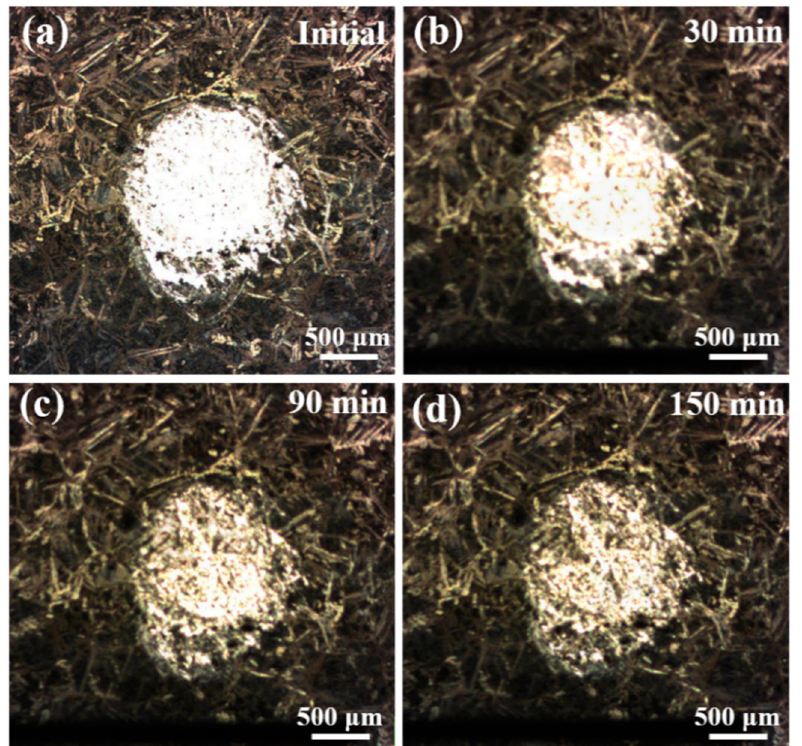
Figure 8. Corresponding optical micrographs of the specimen in the in-situ SVET measurement: ( a ) initial; ( b ) 30 min; ( c ) 90 min; ( d ) 150 min.